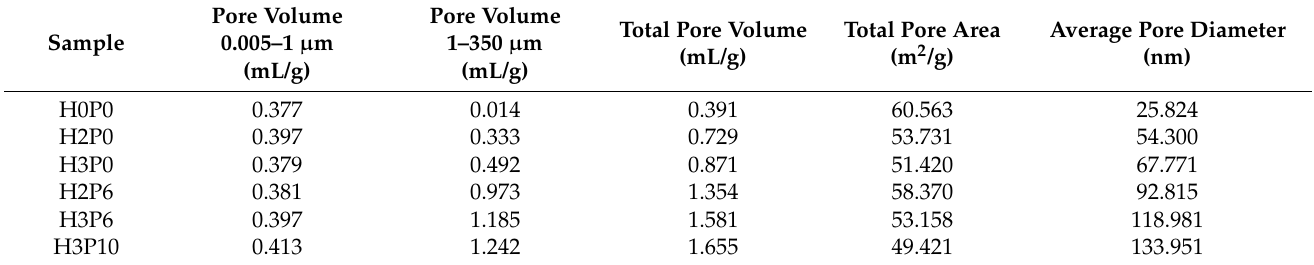
Table 3. Pore volume, pore area, and average pore diameter of geopolymer foams from MIP.